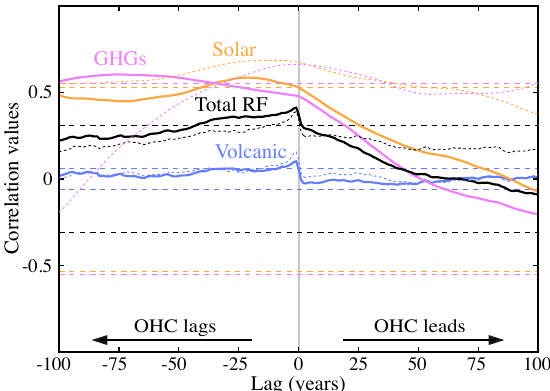
Fig. 11. Time-lag correlations in the whole FOR2 simulation be- tween the OHC700 changes and the different radiative forcings. The thin coloured horizontal lines represent the threshold value for sig- nificance associated with each forcing. Dotted thin lines correspond to similar correlations but calculated for the period 1000–1700 (with no 11yr solar cycle represented). Significance is assessed as in Fig.